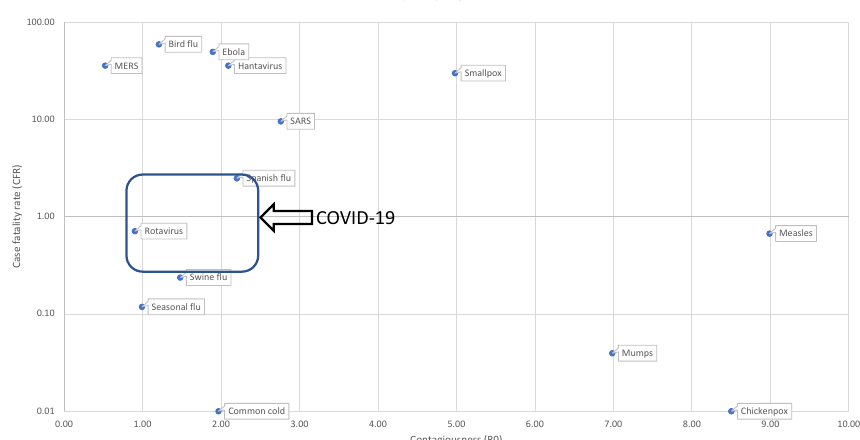
Figure 1. Transmissibility vs. fatality rates of various diseases. At this point, these variables are still uncertain for COVID-19. Source: Thomas-Rüddel et al.